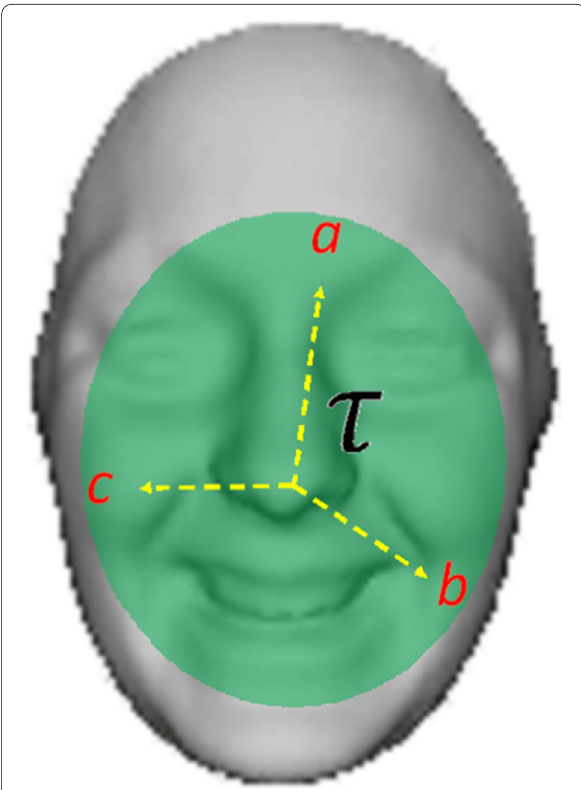
Fig. 3 Ellipsoidal face model Fig. 4 Model of feature extraction points in